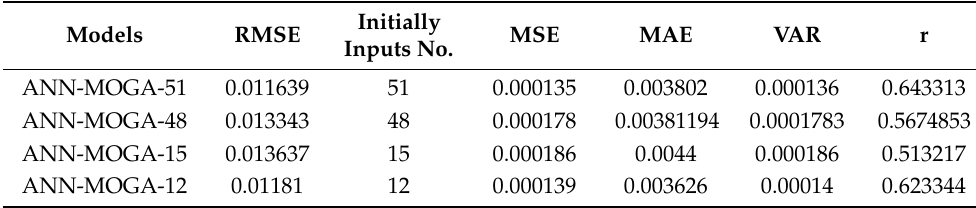
Table 3. Performance comparison of the hybrid multi-objective GA-based ANN forecasting models in the testing phase.